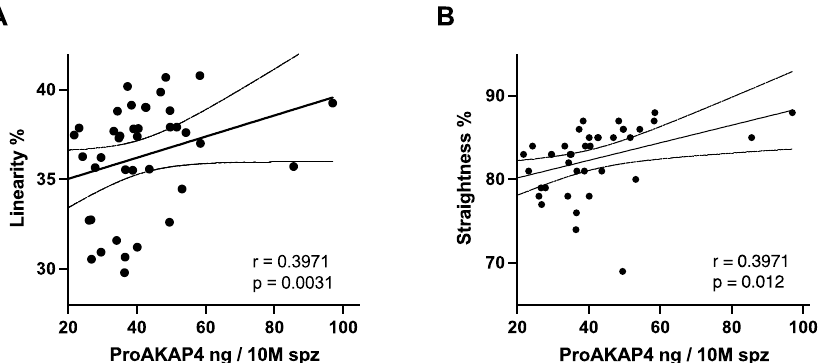
Figure 3. Correlation of linearity ( A ) and straightness ( B ) with proAKAP4 concentrations in post thawed bull semen. ( A ) Linearity ( B ) straightness of spermatozoa and concentrations of proAKAP4 in ng par 10 million of spermatozoa (ng/10 M spz).